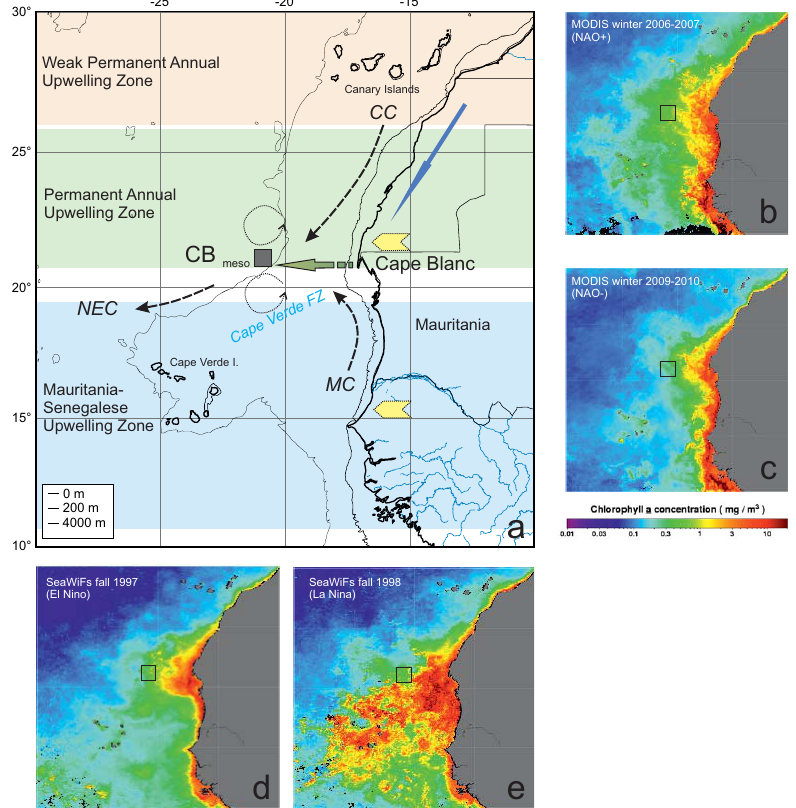
Figure 1. General setting of the study area: (a) Oceanographic setting in the area of the long-term mooring site Cape Blanc (CB meso ) within the Cape Blanc filament (green arrow), dissolving into eddies (indicated as circles with arrows) further offshore. The Cape Verde Frontal Zone (CVFZ) separating the subsurface water masses of the NACW and the SACW (Zenk et al., 1991) is shown. Upwelling zones are marked according to Cropper et al. (2014). Ocean colour map (chlorophyll, 9km resolution) from MODIS is shown for 2 extreme years, winter 2006–2007 ( b , NAO + ) and winter 2009–2010 ( c , NAO − ). SeaWiFS ocean colour during two contrasting situations for the strongest ENSO cycle 1997–1999: autumn 1997 during the warm El Niño phase (d) , and autumn 1998 during the cold La Niña event (e) . The study site CB meso is indicated by a square box in the ocean colour pictures, green arrow indicates the Cape Blanc filament, yellow arrows the major dust transport. MC = Mauritanian Current, CC = Canary Current, NEC = North Equatorial